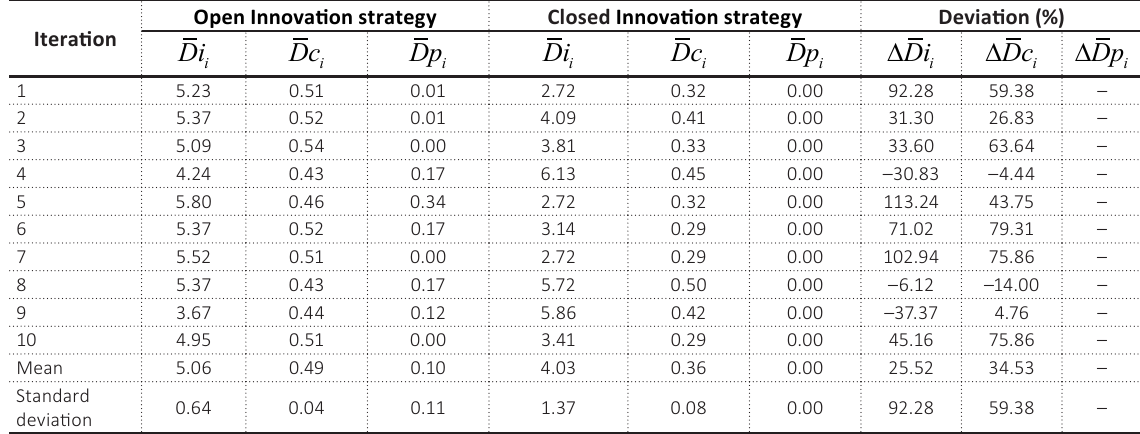
Table 1. Criteria for the effectiveness of organizational structure of 8 subjects (actors, agents) of healthcare institutions from the standpoint of the Open Innovation or Closed Innovation cooperation strategy